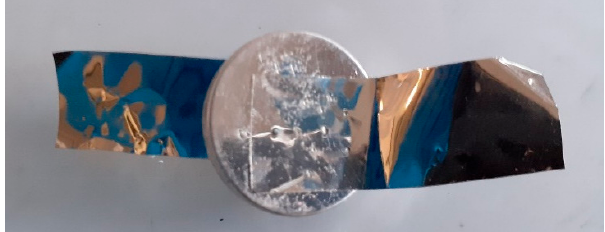
Figure 13. Image of an individual coin cell with welded connections prepared to be tested.